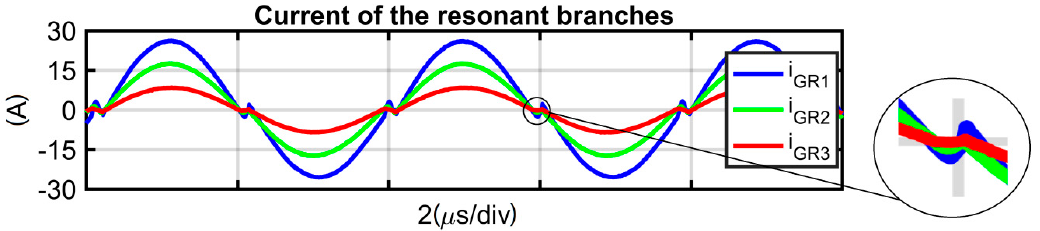
Figure 3. Simulation result of the 5 kW 500 V / 2 kV MRSCC in the base configuration in PSpice (plotted in MATLAB) with C oss and other parasitics.